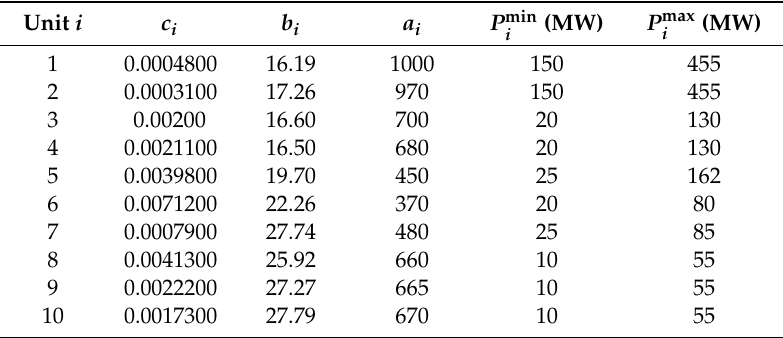
Table A2. All of the data for the 10-unit system.